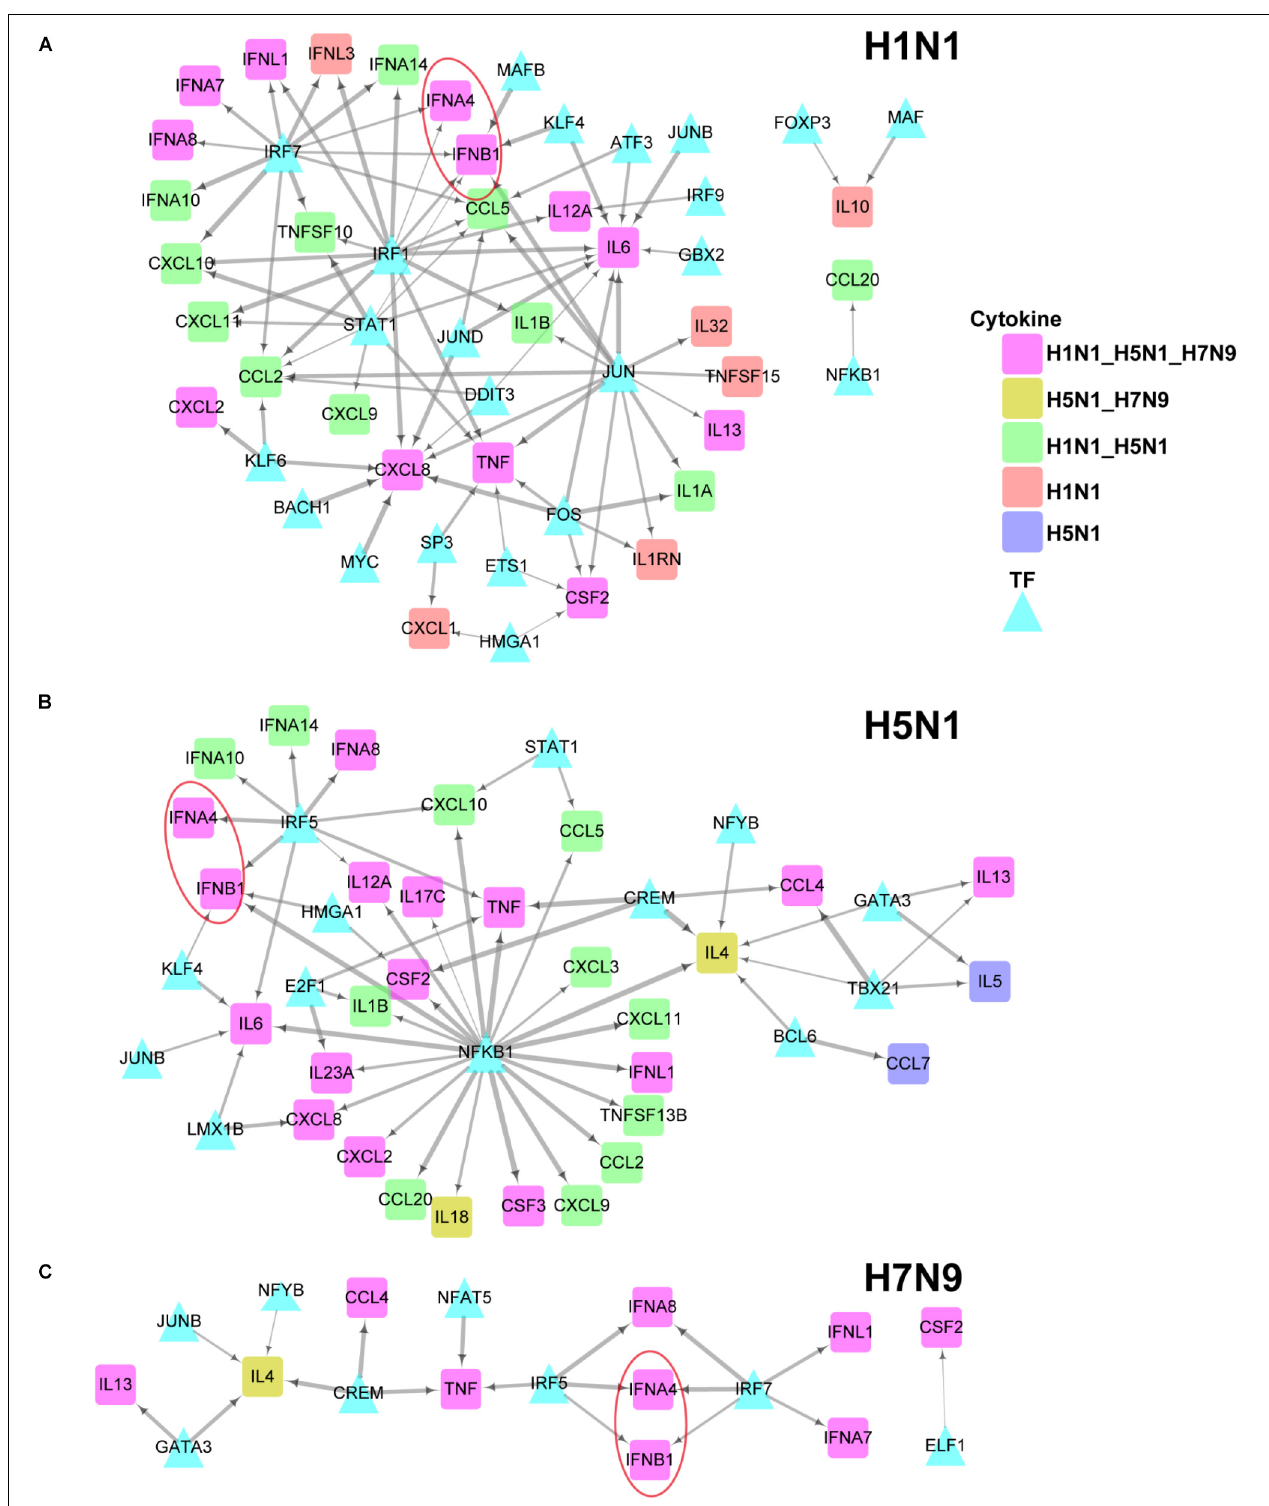
FIGURE 5 | IAV strain-specific regulatory network of cytokines. (A–C) H1N1, H5N1 and H7N9 specific cytokine transcriptional regulation network. The different node colors represent differentially expressed cytokines specific for one strain or shared by two or more strains. The wider edges represent larger PCCs between a pair of TF and cytokine